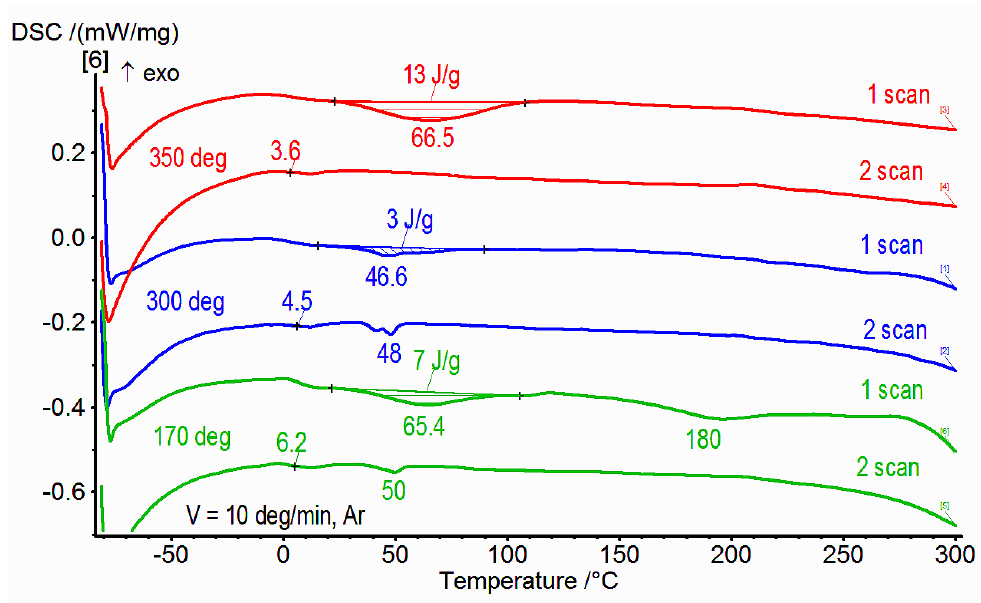
Figure 2. DSC curves of copoly(urethane-imide) samples thermalized for 30 min at temperatures: 170 °C (green curves), 300 °C (blue curves) and 350 °C (red curves).